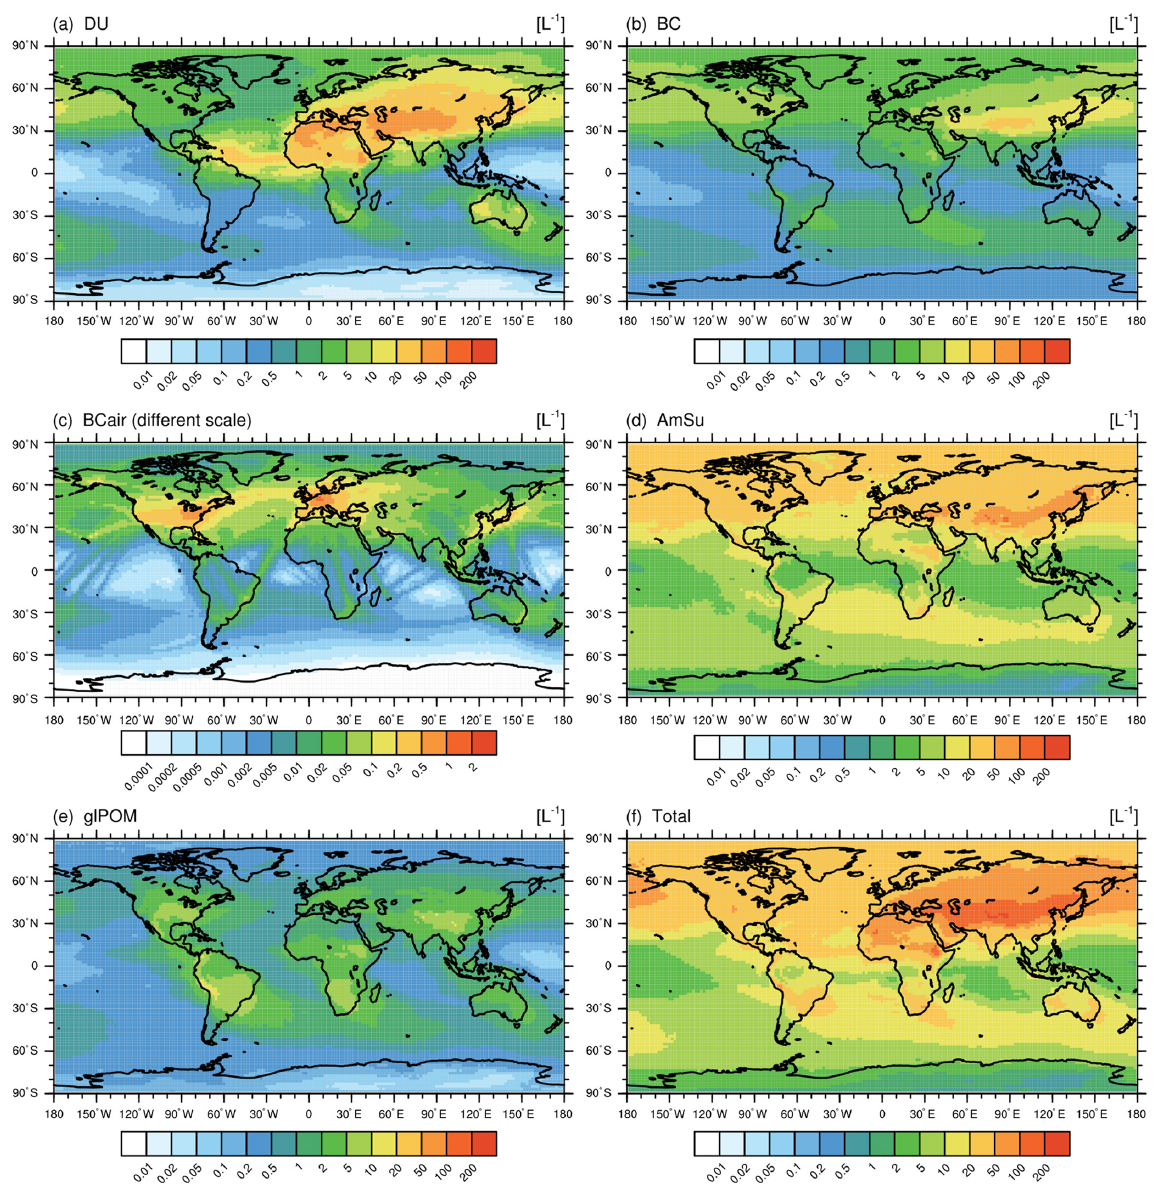
Figure 5. Global distribution of the simulated number concentrations of different INPs per litre (L − 1 ) inside cirrus clouds (selecting only grid boxes with cirrus occurrence) considering the multi-year average over the simulation period (2010–2019) and over all vertical levels. Shown are mineral dust (DU; a ), black carbon (BC; b ), black carbon from aviation (BCair; c ), ammonium sulfate (AmSu; d ), glassy organ- ics (glPOM; d ), and total INP concentrations (f) . Cirrus conditions are selected according to thresholds for simulated ambient temperature ( T < 238K) and ice water content (IWC > 0.5mgkg − 1 ) in every grid box using the 11h output frequency. The number concentrations of potential INPs (see calculations in Sect. 3.4) are weighted with ice-active fractions ( f act ) at ice supersaturations of S i = 1 . 4, from laboratory measurements (see Table 1). Note the different scale in panel (c)